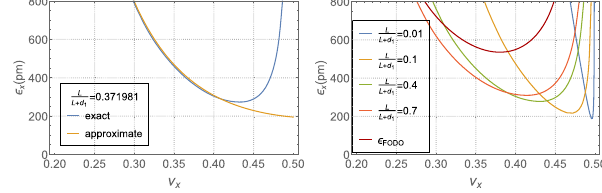
FIG. 7. Exact and approximate mTME emittance (left) as a function of tune. The mTME emittance for different ratios of the magnet and cell lengths (right). The red curve is FODO emittance.